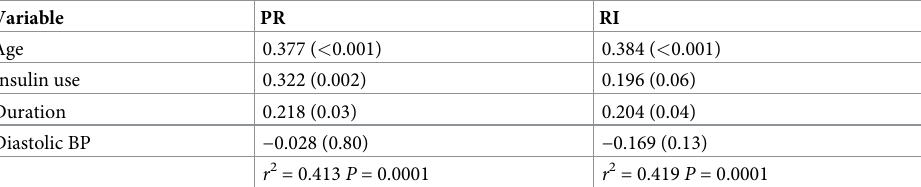
Table 6. Multiple regression analysis of PR and RI in 68 patients with type 2